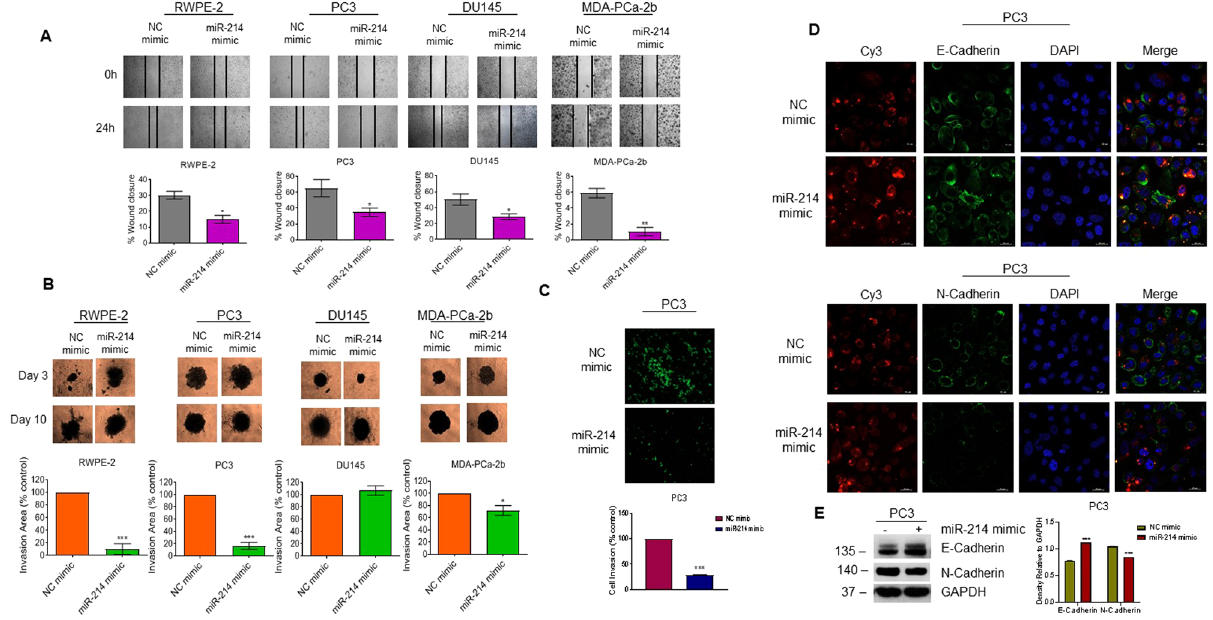
Figure 3. Effects of miR-214 overexpression on prostate cancer cell migration and invasion. ( A ) Wound healing assay: RWPE-2, PC3, DU145, and MDA-PCa-2b cells were transfected with NC or miR-214 mimic for 48 h. The effect of the miR-214 expression on cell migration was analyzed using the wound healing assay. Representative images of the wound healing assay (top) and the calculated scratch area (bottom) are shown. (B) 3D spheroid invasion assay: RWPE-2, PC3, DU145, and MDA-PCa-2b cells were transfected with NC or miR-214 mimic and then analyzed using the 3D spheroid assay. 3D spheroid images (top) and the quantified 3D invasion area (bottom) were determined by subtracting pre-invasion (day 3) from post-invasion (day 10) area. ( C ) Trans- well invasion assay: PC3 cells were transfected with NC or miR-214 mimic. After 48 h, the effect of miR-214 mimic on cell invasion was analyzed by trans-well invasion assay in miR-214-transfected PC3 cells stained with Calcein-AM (Green fluorescence, top) and quantified (bottom). The invasion assay was performed in duplicate, and results are representative of three independent experiments. (D , E) The effects of NC or miR-214 mimic transfection on the expression of E-Cadherin (top, green) and N-Cadherin (bottom, green) in PC3 cells were analyzed by ( D ) immunofluorescence and ( E ) western blotting. * P < 0.05, ** P < 0.005, *** P < 0.0005 compared with NC-transfected